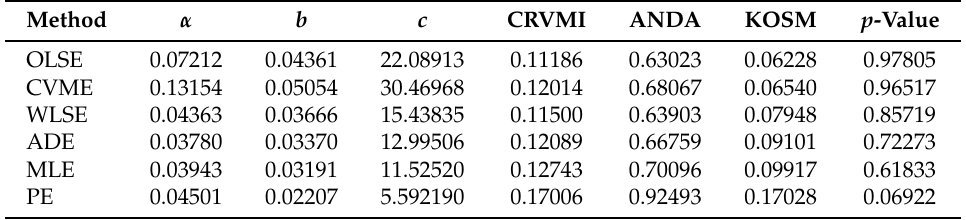
Table 6. The estimates of the APExE parameters along with goodness-of-fit measures for insurance